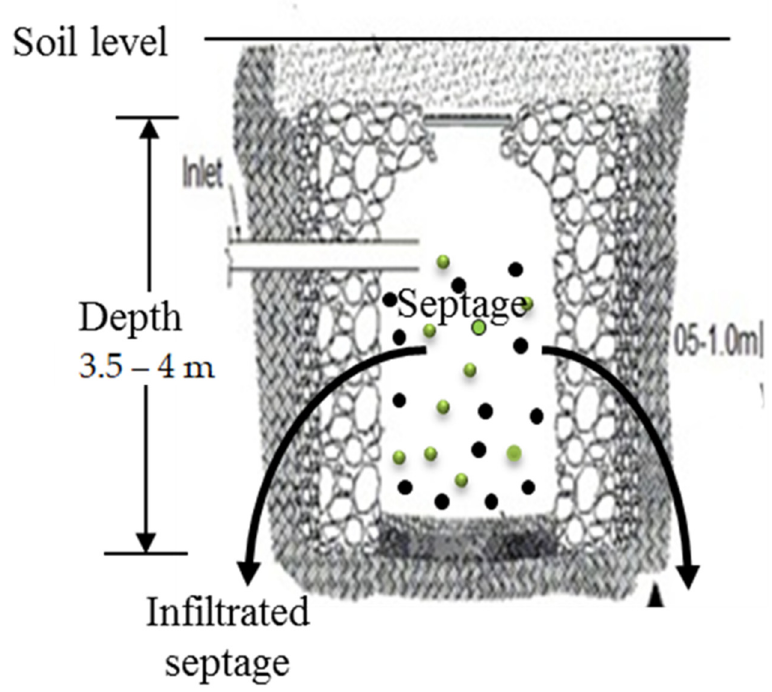
Figure 1. Cesspit schematic drawing